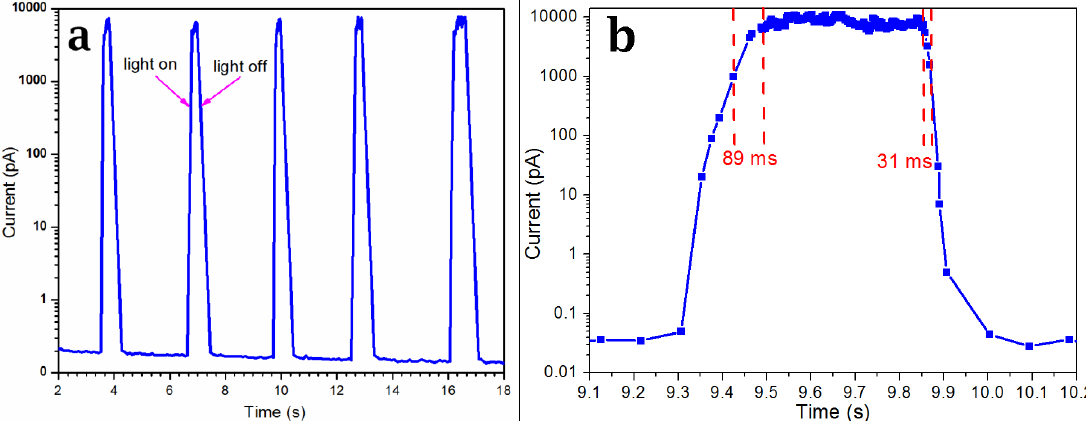
Figure 7. The Schottky barrier energy band diagram and the photoresponse mechanism: when light was on, the photo generated holes will recombine with the adsorbed oxygen on the nanobelt surface. The surface depletion layer thickness and the Schottky barrier E were reduced. E and E were the conductance band and valance band of the CdS Cs Vs nanowire; E and E were the Fermi level and conductance band of the metal. E fm Cm Schottky